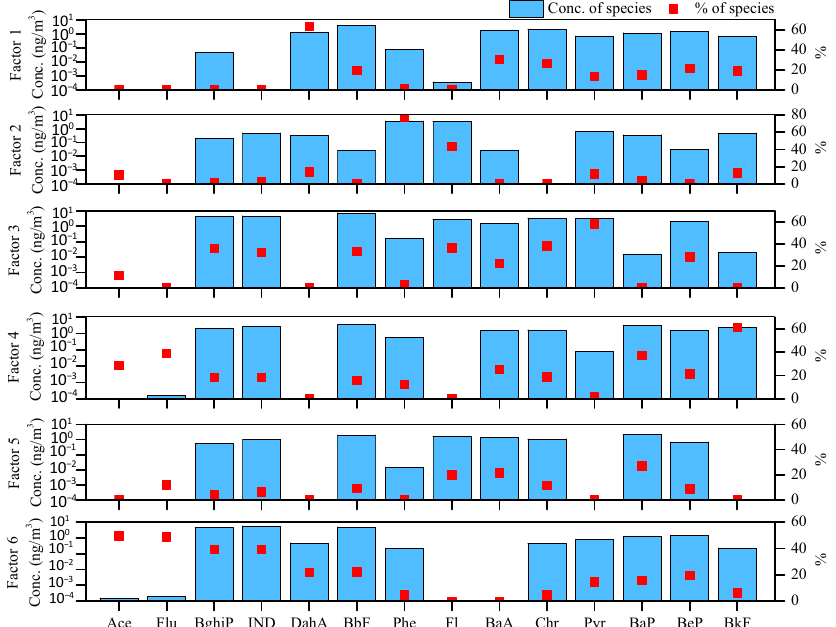
Figure 1. Source profile of personal PM 2.5 − bound PAH exposure. Conc., the abbreviation for concentration; % of species, the percentage of species; Ace, acenaphthene; Flu, fluorene, Phe, phenanthrene; Fl, fluoranthene; Pyr, pyrene; BaA, benz[a]anthracene; Chr, chrysene; BbF, benzo[b]fluoranthene; BkF, benzo[k]fluoranthene; BeP, benz[e]pyrene; BaP, benzo[a]pyrene; DahA, dibenz[a,h]anthracene; BghiP, benzo[ghi]perylene; IND, indeno[1,2,3 ‐ cd]pyrene. Factor 1 was dominated by DahA (63.8%) and moderately loaded by BaA (30.6%) and Chr (26.6%). DahA was used as the indicatory PAH for biomass burning [28], and BaA